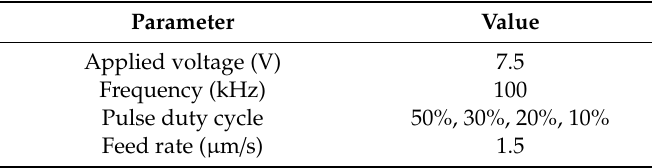
Table 1. Machining parameters with different pulse duty cycle.